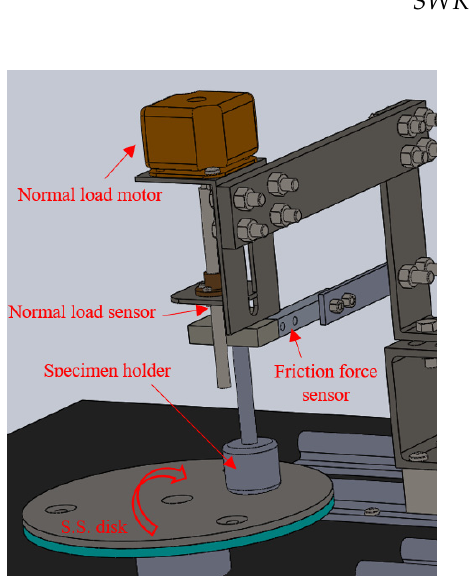
Figure 2. Pin-on-disk tribometer.